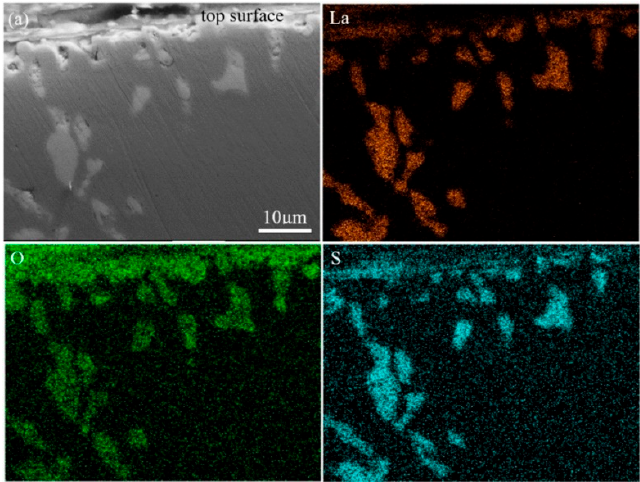
Figure 2. Morphologies and distribution of La 2 O 3 and La 2 O 2 S inclusions. ( a ) Morphologies of the top surface of the ingot.